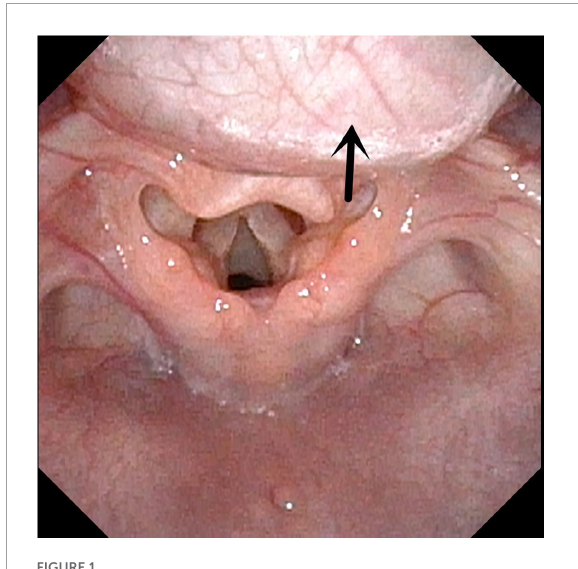
FIGURE3 Bilateral vocal cord paralysis. Both arrows indicate the bilateral vocal cord paralysis.